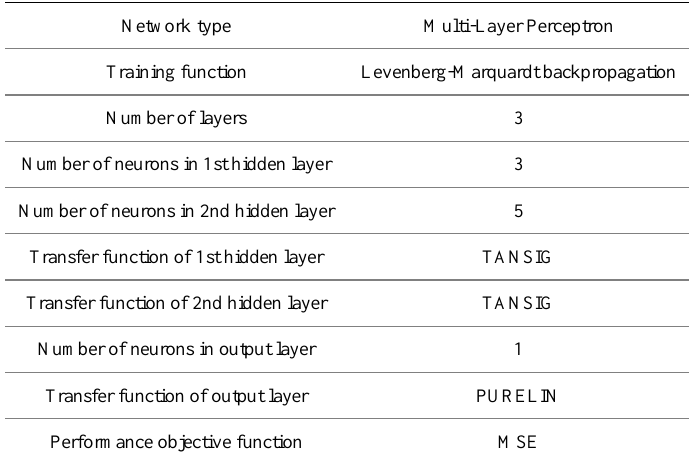
Table 2. Structure of the MLP network developed to predict